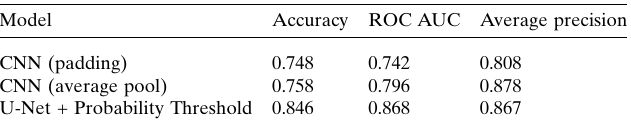
Table 4 Performance of hole classification CNNs on hold-out sessions. ROC AUC: area under receiver operating characteristic curve.